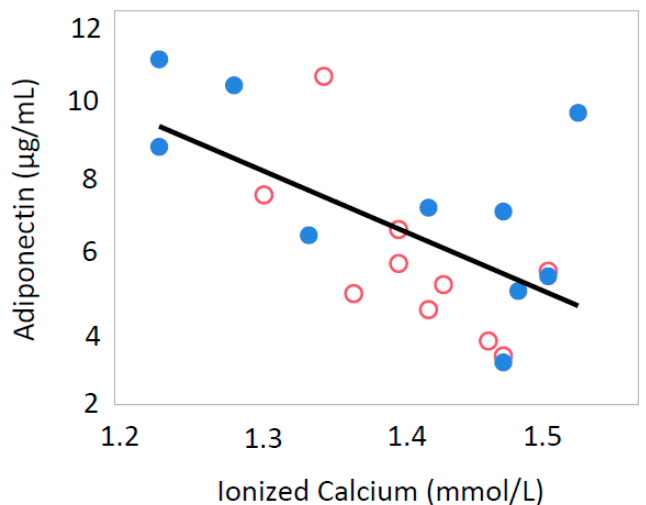
Figure 1. Relationship between ionized calcium and serum adiponectin levels in all male rat offspring (R = − 0.605, p = 0.0037). Open circle, male offspring from control group; closed circle, male offspring from Ca-deficient group.